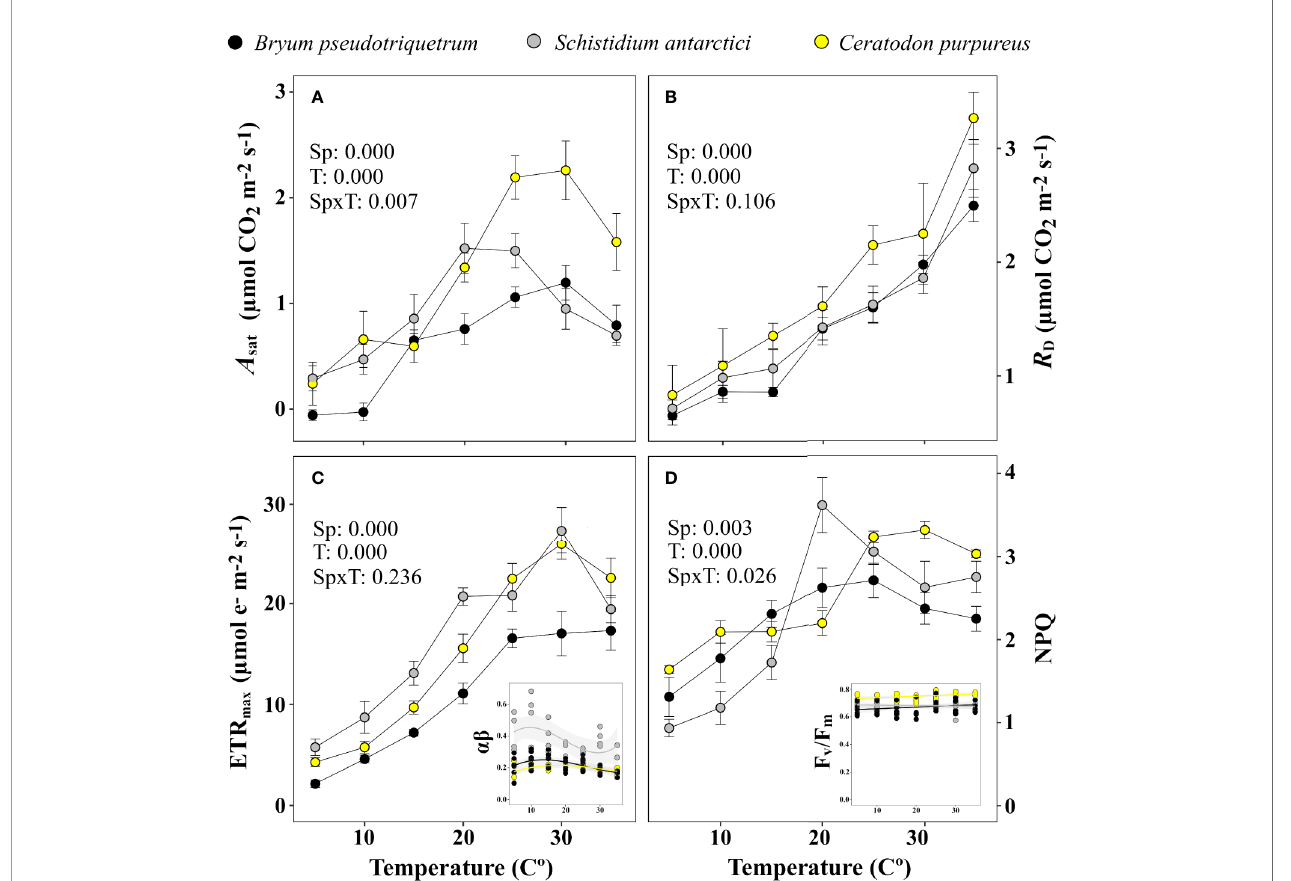
FIGURE 7 | Temperature response curve of three East Antarctic moss species for (A) saturating net CO 2 assimilation ( A sat ), (B) dark respiration ( R D ), (C) maximum electron transport rate (ETR max ), and (D) non-photochemical quenching (NPQ). Inset graph of (C) shows variation in the product of absorbance and partitioning of photons ( ab ) used for calculation of ETR across temperature ( R 2 = 0.068, 0.063, and 0.095 for C. purpureus , S. antarctici , and B. pseudotriquetrum , respectively). Inset graph of (D) shows stability of F v /F m across temperature ( R 2 = 0.086, 0.028 and 0.046 for C. purpureus , S. antarctici and B. pseudotriquetrum , respectively). P values results from two-way ANOVA are shown in the upper-left corner of each graph. Mean ± se ( n = 4-6, except for the light curve derived parameter ab , where n = 3-5).